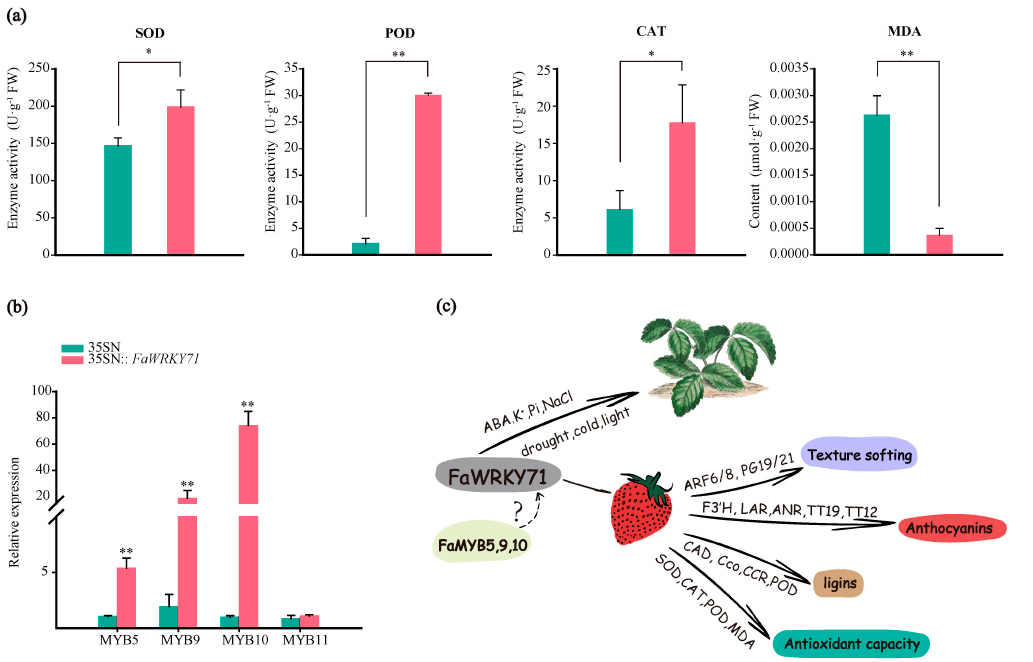
Figure 5. The activity of antioxidant enzymes in FaWRKY71 overexpressed samples and Regulatory model of FaWRKY71 in strawberry. (a) Enzymes activity of SOD, POD, CAT and the content of MDA. Error bars were SEs for three replicates, and statistical significance was determined by Student’s t-test (**, P < 0.01; *, P < 0.05). (b). Relative expression of MYBs in FaWRKY71 overexpressed samples. (c) A model indicating how FaWRKY71 regulates strawberry ripening.